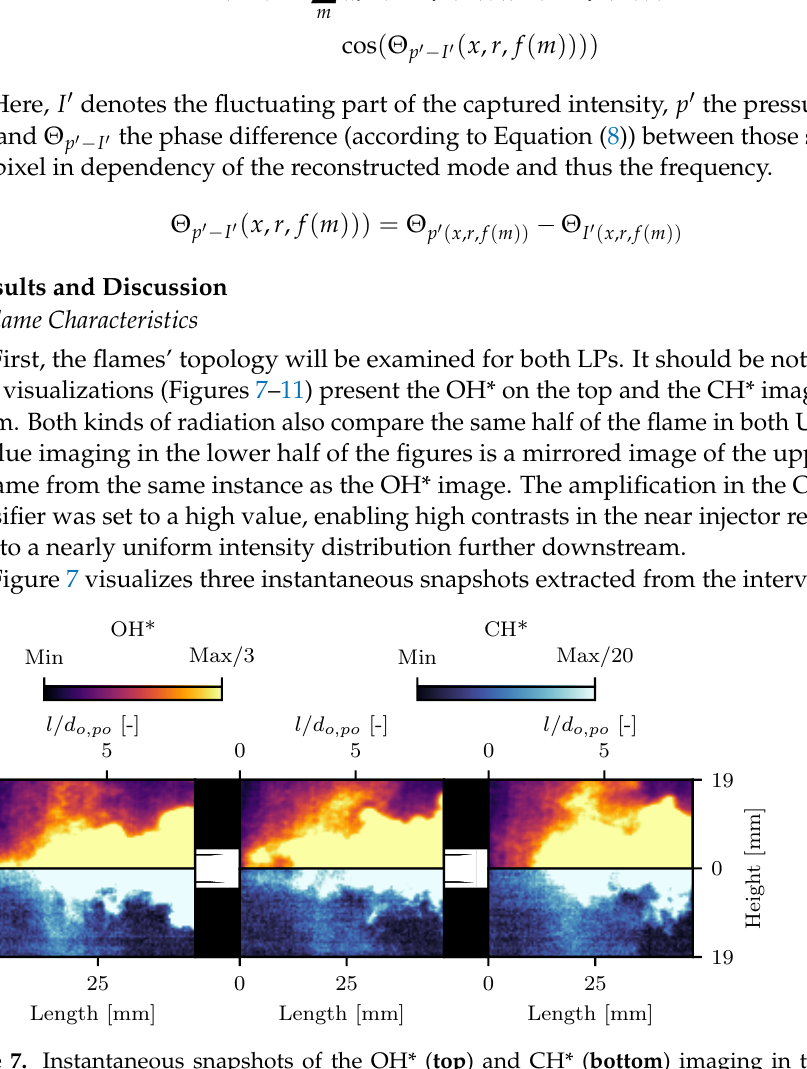
Figure 7. Instantaneous snapshots of the OH* ( top ) and CH* ( bottom ) imaging in the interval between 9.1 and 9.5 s of LP1 with three different kinds of flame anchoring